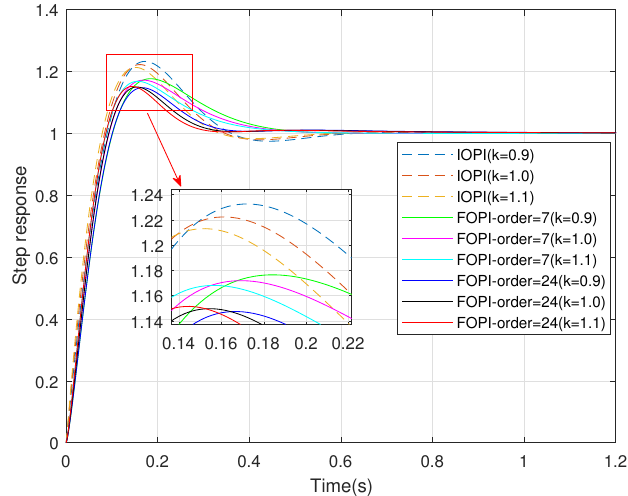
Figure 15. Step responses with loop gain